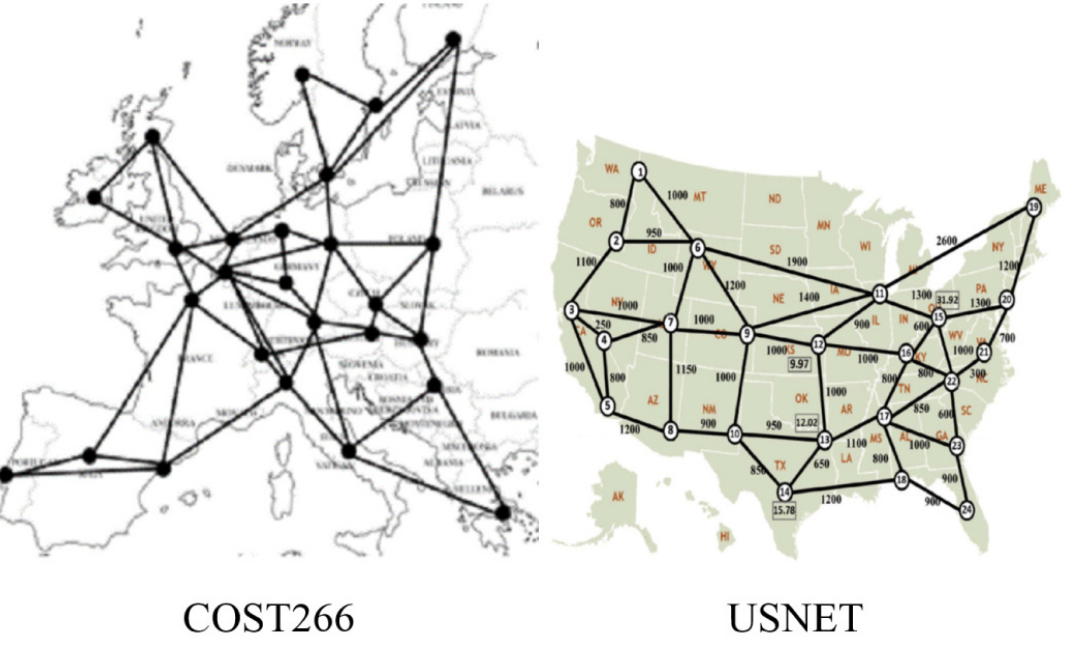
Figure 5. Euclidean (geographically accurate) COST-266 European and US NSF networks [7]. Note the additional links since the publication of the library: adapted from [25].